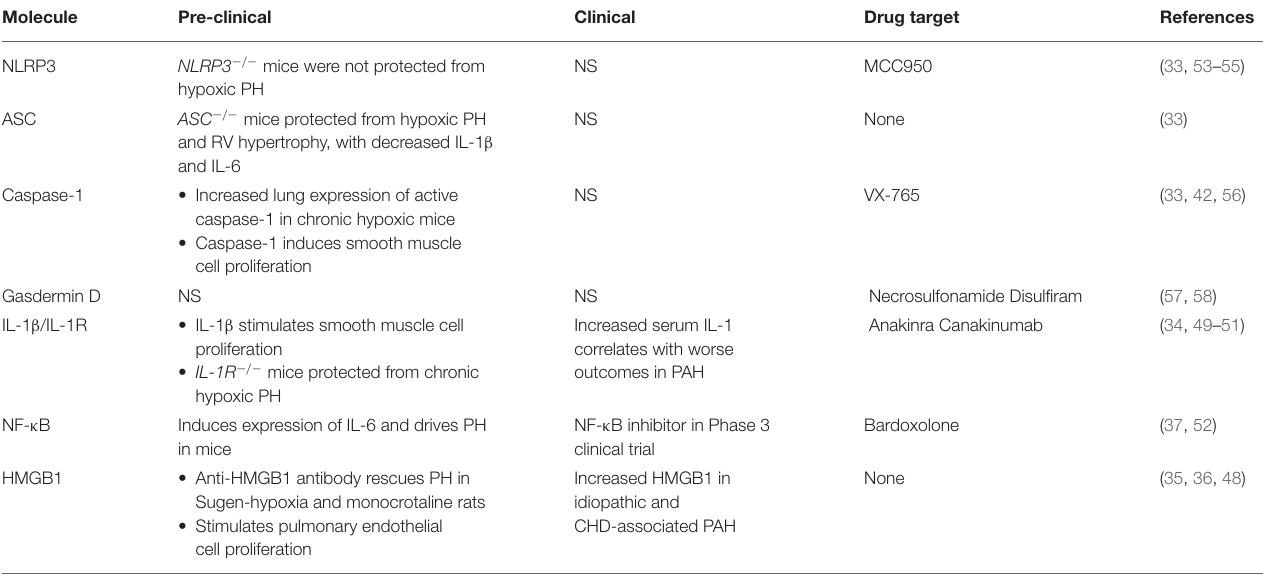
TABLE 1 | Pre-clinical and clinical evidence for inflammasomes in PAH.